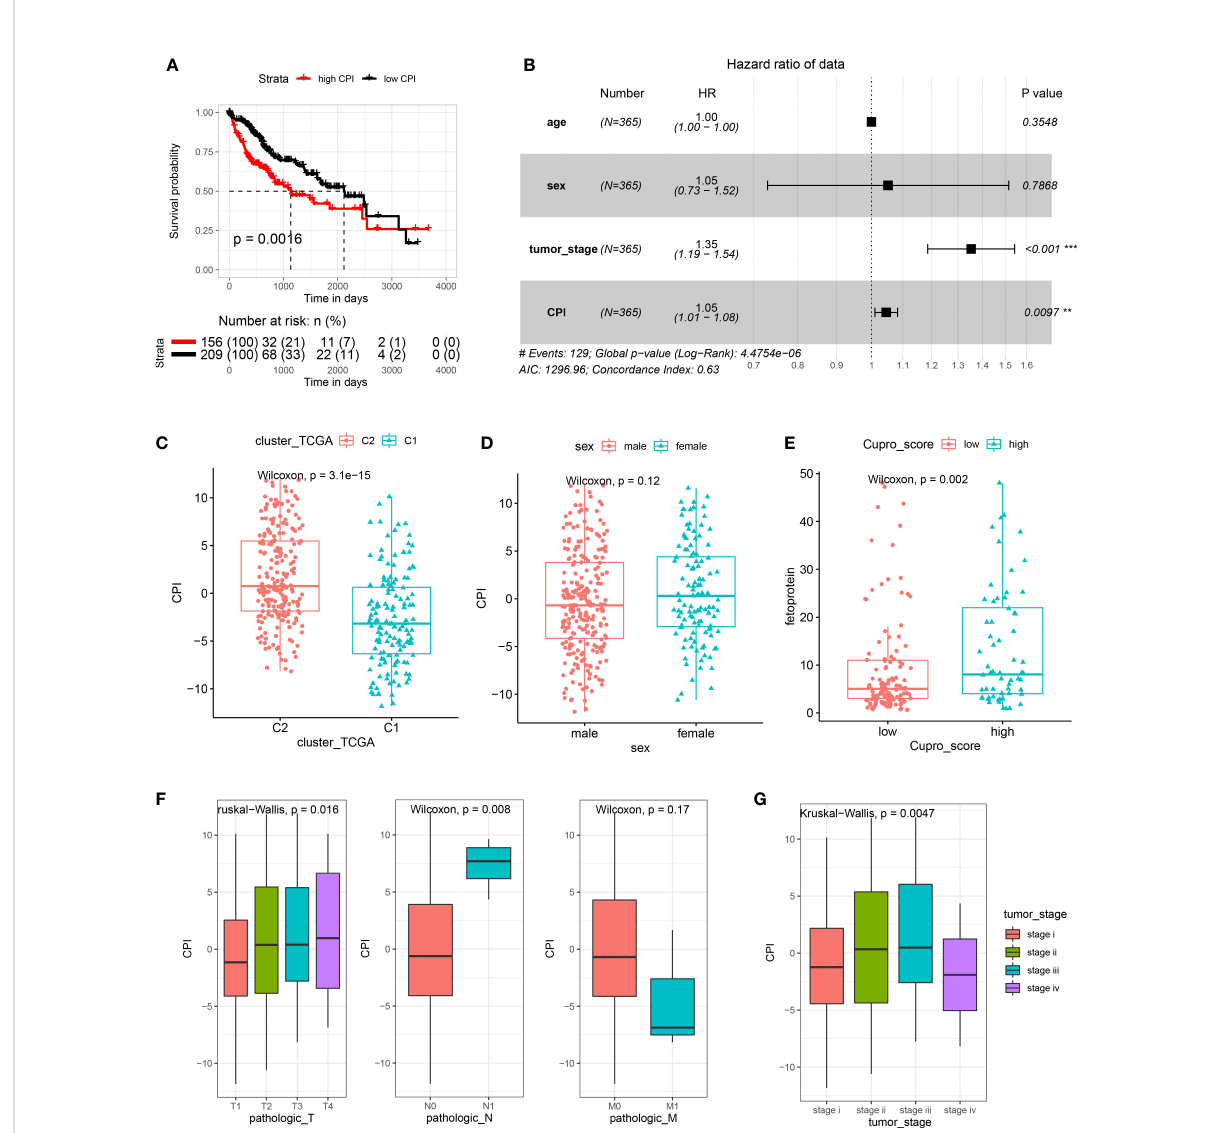
FIGURE 7 Establishment and evaluation of the cuproptosis index (CPI). (A) Results of KM analysis indicating that the CPI signi fi cantly in fl uenced the survival of patients in TCGA. Red line represents the high-risk group and dark line the low-risk group. (B) Results of the multivariate analysis based on TCGA-LIHC. (C) Boxplots showing cuproptosis-C2 was associated with high CPI scores. (D) CPI scores failed to show a statistically signi fi cant difference between genders. (E) High CPI scores were associated with high levels of alpha fetoprotein. (F) Boxplots showing that TNM stage was associated with distinct CPI scores. (G) Advanced tumor stage was related with high CPI